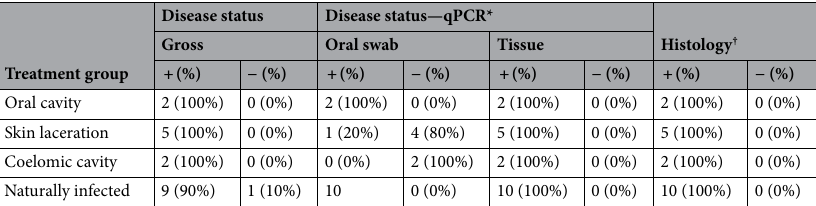
Table 5. Infection status of Asian house geckos given antibiotics at the end of the treatment period. *A gecko was defined as qPCR positive for E. lacertideformus when the oral swab and/or tissue samples returned a positive result. † A gecko was defined as histologically positive for E. lacertideformus when characteristic organisms were observed in the